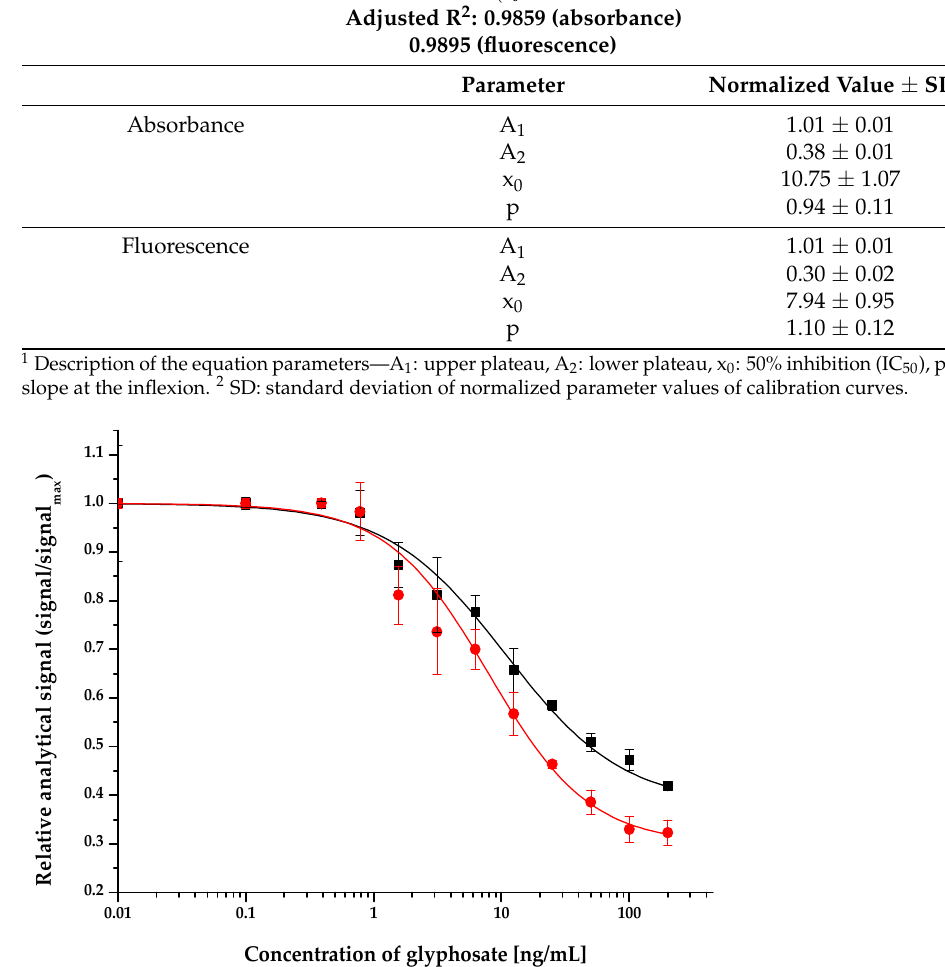
Figure 1. Competitive indirect calibration curves for glyphosate determined by absorbance (black) and fluorescence (red).